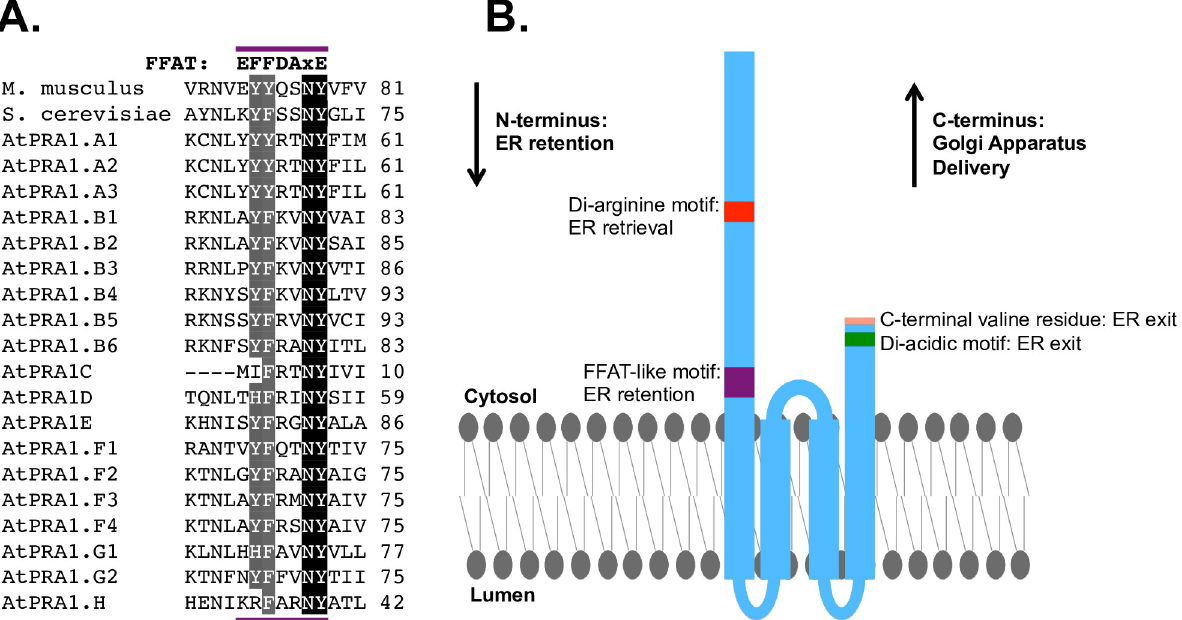
Fig 6. Proposed model for PRA1 trafficking in mammalian cells. (A) Sequence alignment of mouse, yeast, and Arabidopsis PRA1 family members shows that the FFAT motif consensus double aromatic residue signature in mammals is also conserved in both fungi and plants. The amino acids NY, which correspond to the “xE” in the classic FFAT motif are completely conserved in mammals, yeast, and Arabidopsis family members. (B) Schematic map of the trafficking motifs superimposed onto full length PRA1. The cytosolic C-terminal region contains both a C-terminal valine and a di-acidic motif previously demonstrated to facilitate ER